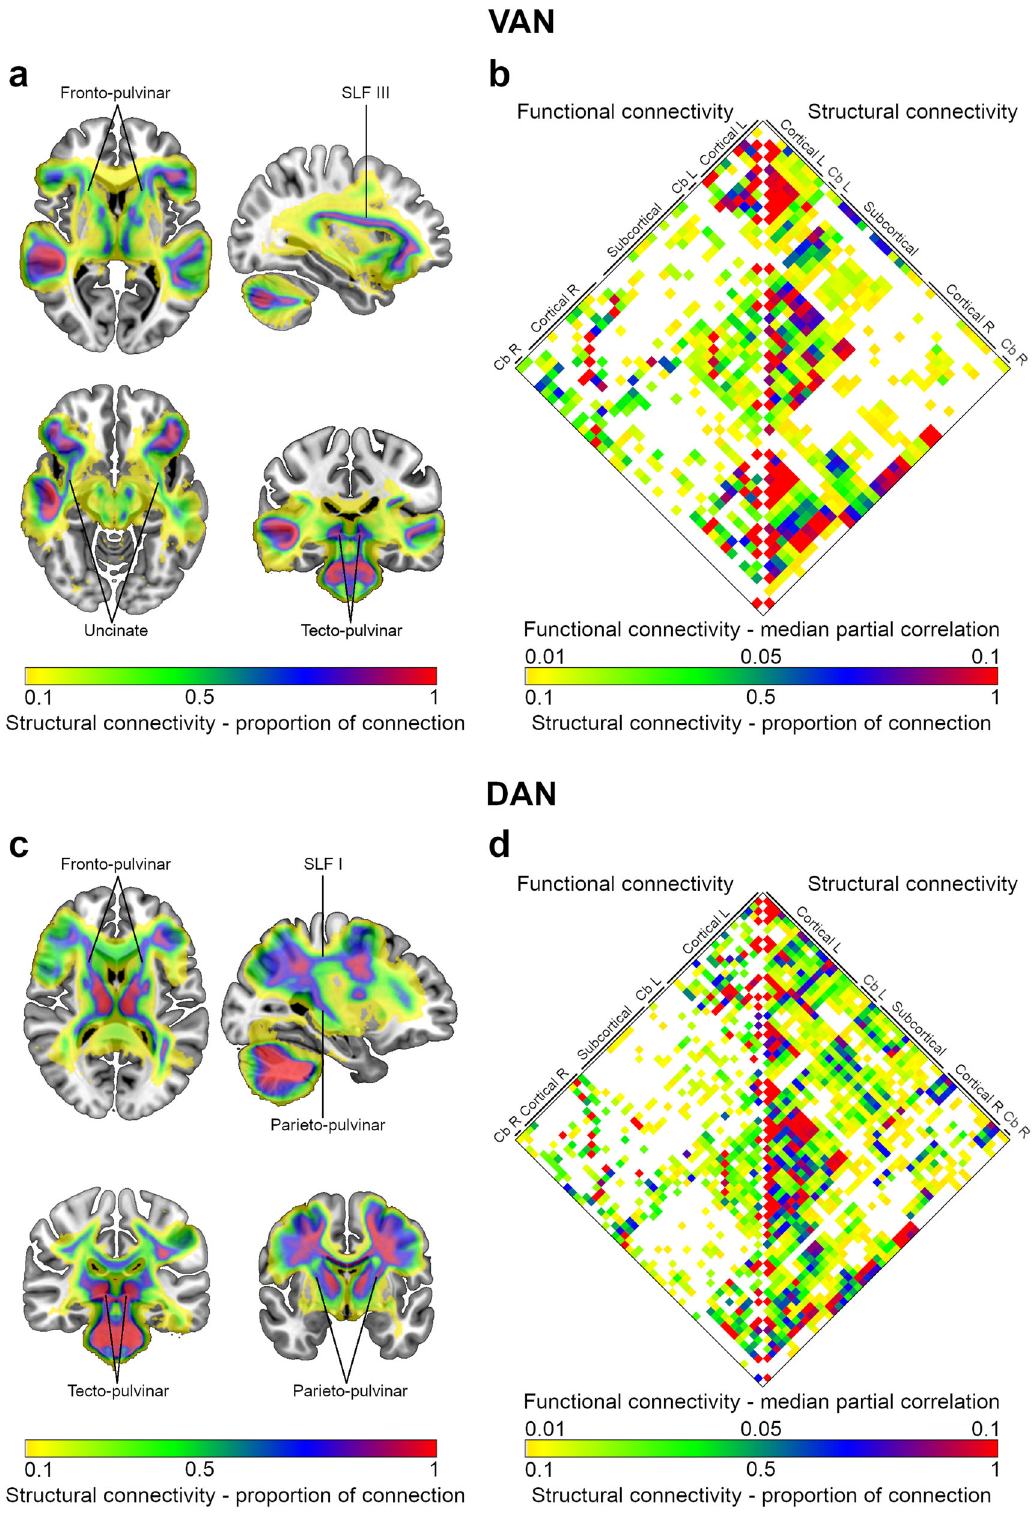
Fig. 3 Structural and functional connectivity of VAN and DAN nodes. a Structural connectivity map of the VAN. b Matrix with the node-to-node functional and structural connectivity of the VAN, represented on the left and right halves, respectively. c Structural connectivity map of the DAN. d Matrix with the node-to-node functional and structural connectivity of the DAN, represented on the left and right halves, respectively. Nodes of the matrices were labeled in groups according to their anatomical location. A complete list with node labels is available in Supplementary Tables 1, 2. As indicated, color gradients represent the structural connectivity (expressed as the proportion of connection) or the functional connectivity (de fi ned as the median partial correlation). Cb cerebellum, L left, R right, SLF superior longitudinal